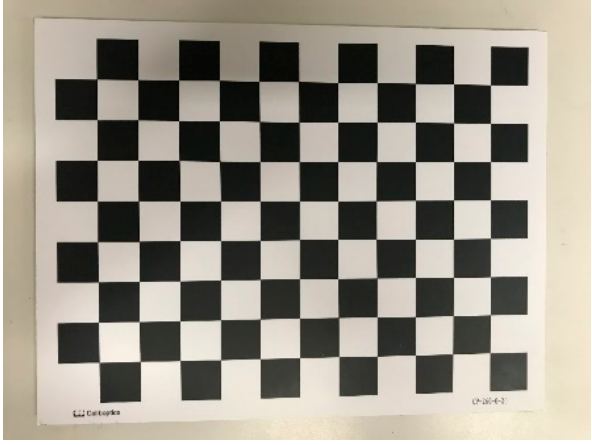
Figure 5. Chess board pattern calibration plate.